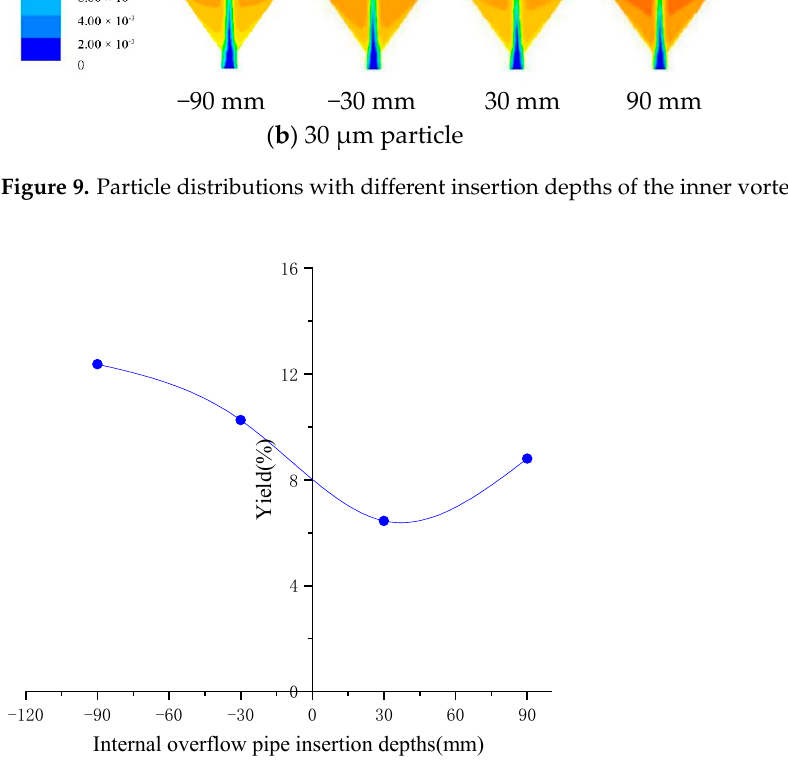
Figure 11. Inner-overflow yield and particle classification for different inner vortex finder inser- tion depths. 3.2. Experimental Study on Separation Performance The slurry mass concentration was set at 18% during the test and the feed pressure to the hydrocyclone was adjusted to 0.10 MPa by means of a centrifugal pump and an in- line valve. In order to verify whether the double-overflow hydrocyclone can obtain three kinds of particle size products, particle size composition analyses were carried out on samples from the internal overflow port, the external overflow port, and the underflow port of the hydrocyclone. The particle size distribution is shown in Figure 12. It can be seen from the figure that after grading by the double-vortex finder hydrocyclone, narrow-grain prod- ucts with cut sizes of 15.3 μ m, 22 μ m, and 19.1 μ m were obtained by one grading of the feedstock.